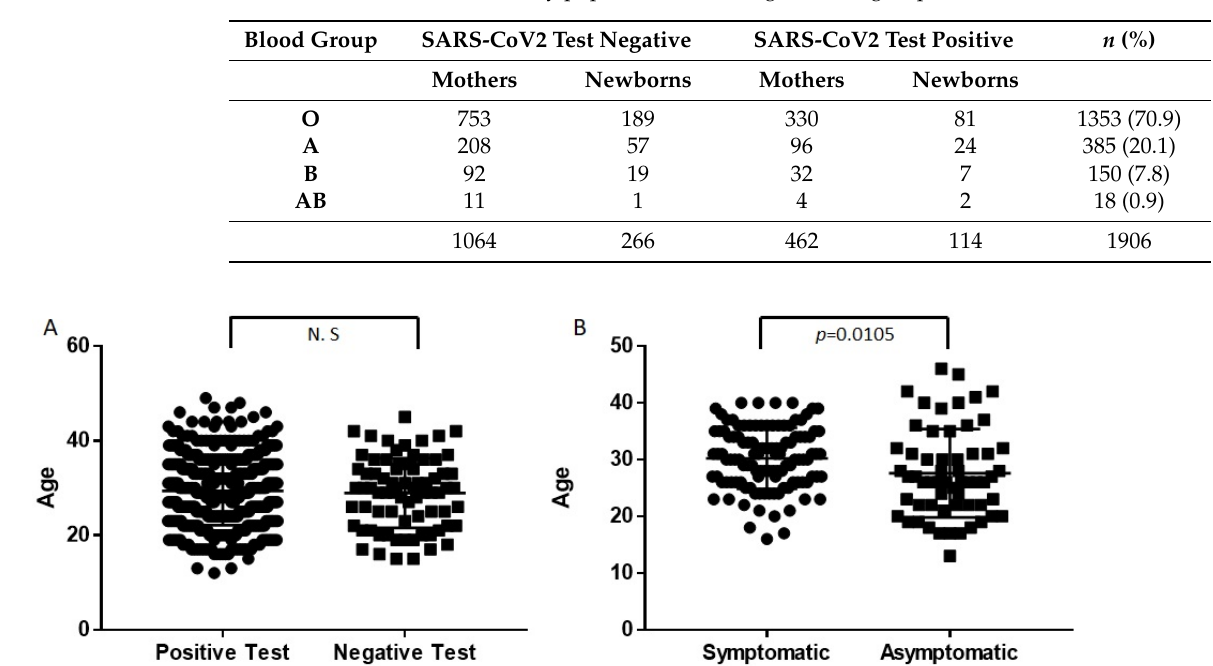
Figure 1. Age comparison. ( A ) Comparison of age between individuals with a positive test for SARS-CoV-2 versus individuals with a negative test revealed no significant differences. ( B ) Mothers with a positive SARS-CoV-2 test were divided into symptomatic and asymptomatic; age comparison between them revealed that symptomatic women were older than asymptomatic ( p = 0.0105). Mean comparison was performed using the Student’s t -test.